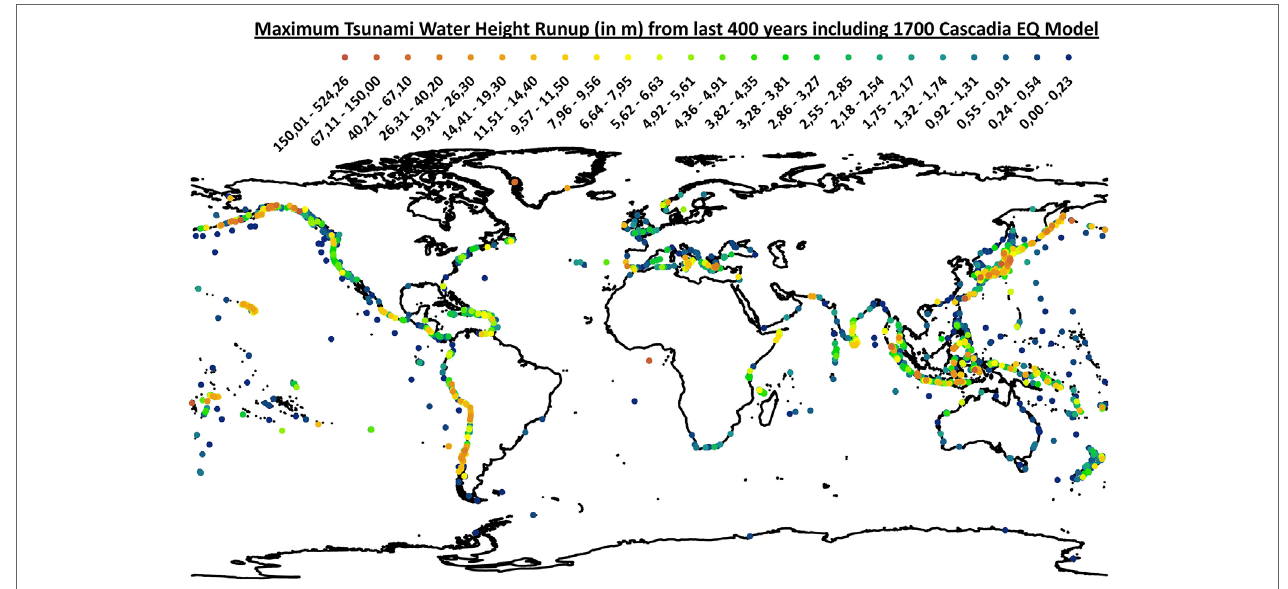
FigUre 2 | Maximum tsunami water height runup (in meters) from the last 400 years from a combination of modeling and national geophysical Data center, including a 1700 cascadia eQ Model .